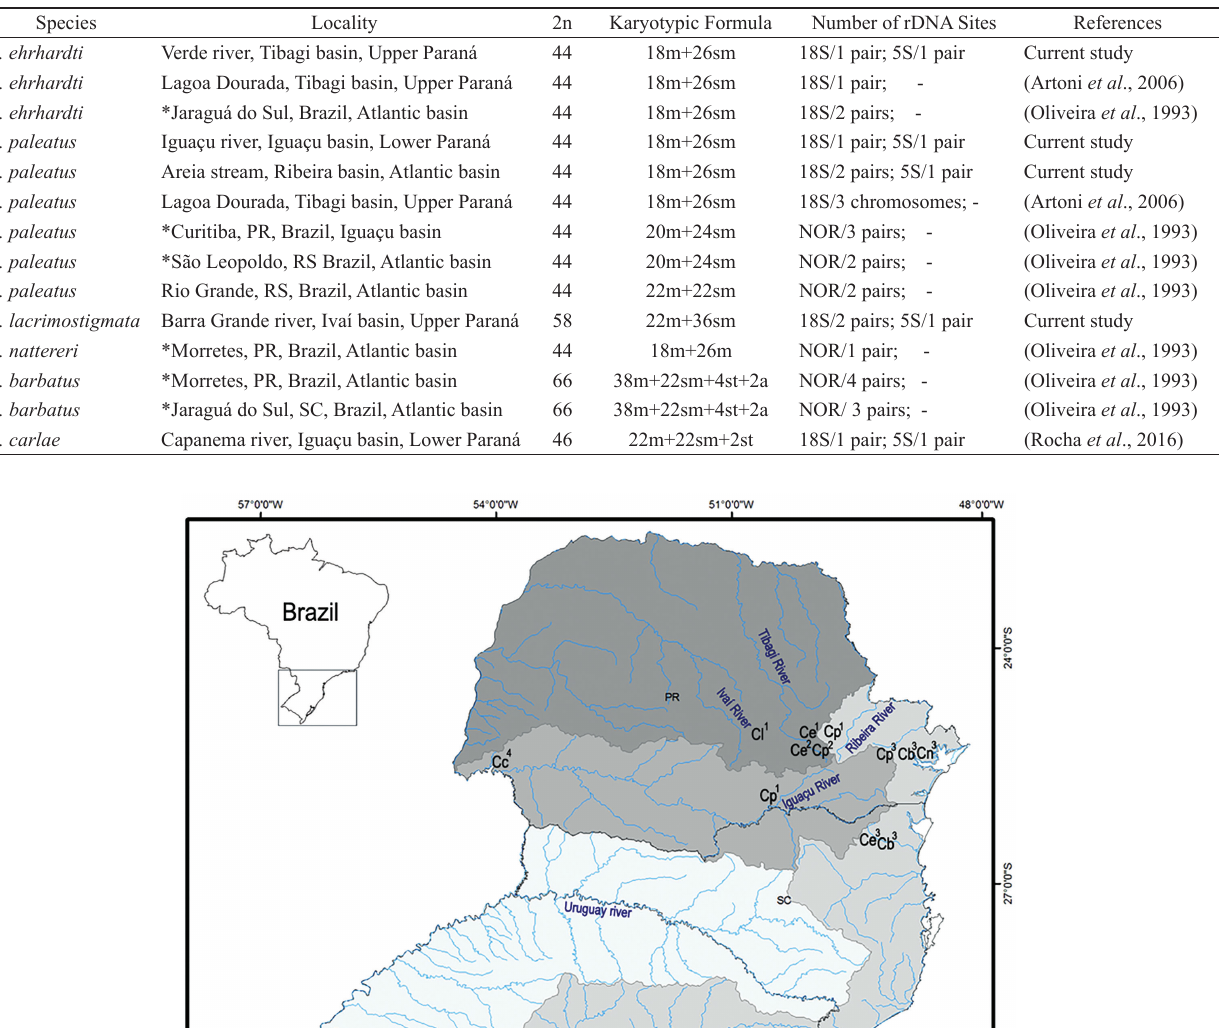
Tab. 1. Cytogenetic data for Corydoras species from southern Brazil. 2n= diploid number; PR = Paraná State; SC = Santa Catarina State; RS = Rio Grande do Sul State; M = metacentric; SM = submetacentric; ST = subtelocentric; A = acrocentric; 18S = number of 18S rDNA sites; 5S = number of 5S rDNA sites; NOR = number of 18S rDNA sites detected by Ag-NOR staining. * The river was not identified in the original paper.